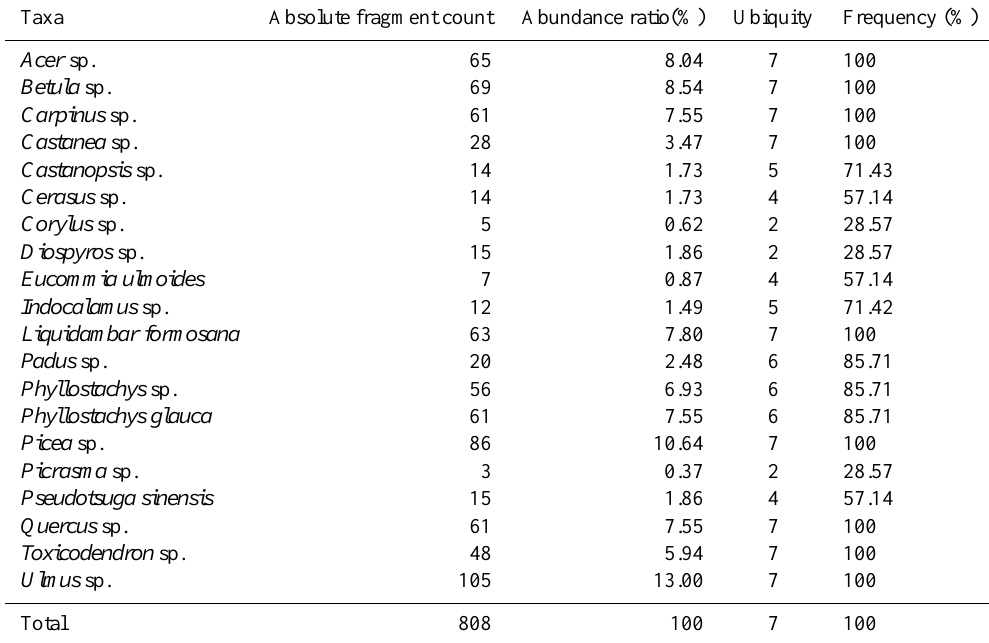
Table 3. The taxa of fossil charcoal and their relative frequencies and abundance ratio from the Xishanping site.